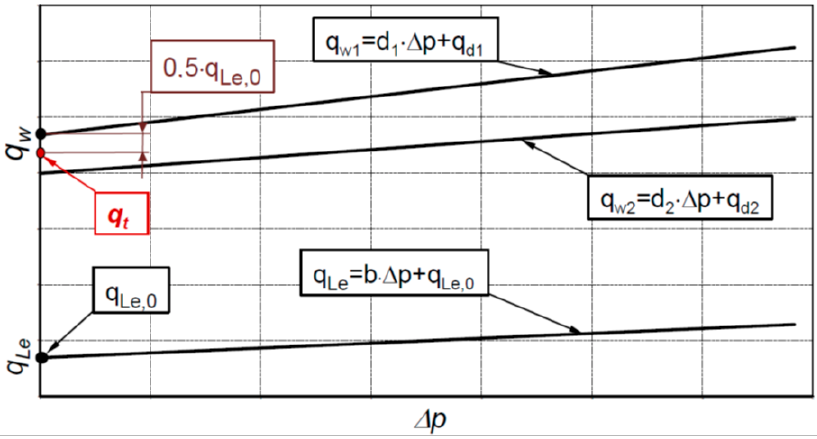
Figure 5. Linear relationship between working volume q w and leakage q Le and pressure drop